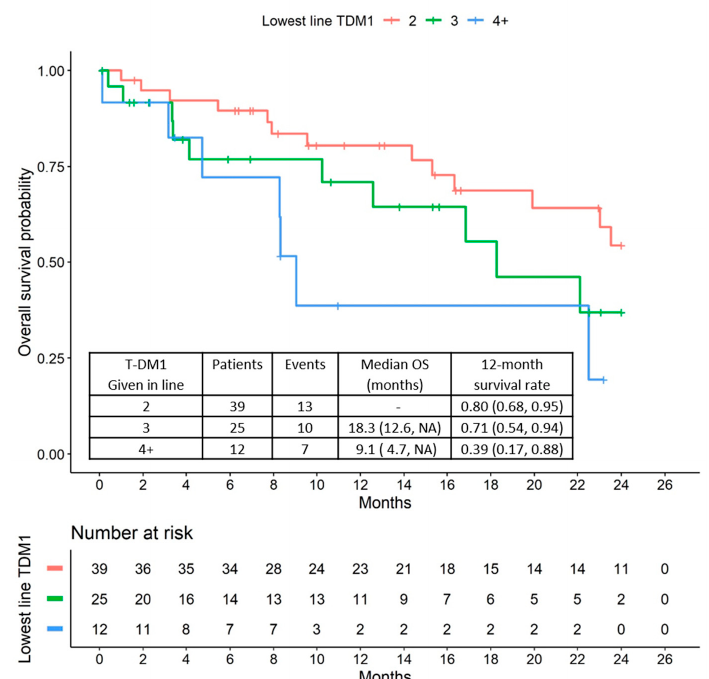
Figure 4. OS relative to T-DM1 treatment line.